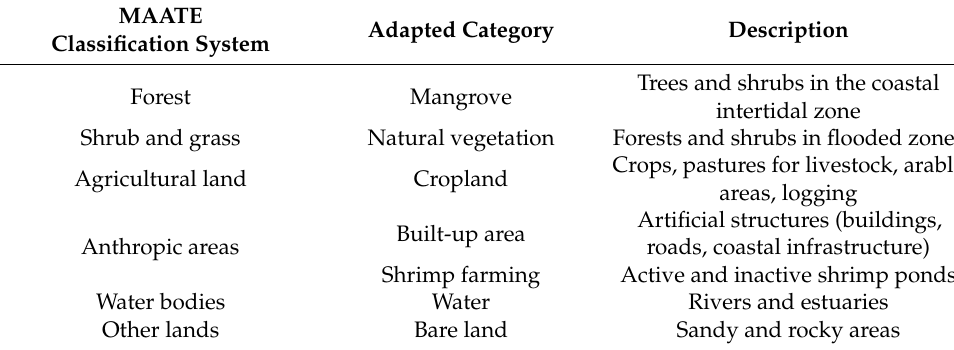
Table 2. Classification system with the land use and land cover categories (LULC) applied in this